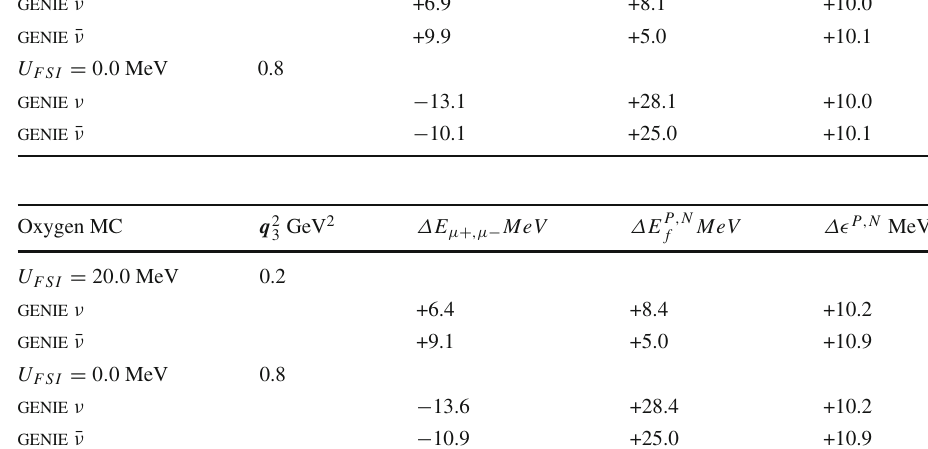
Table 10 Estimates of the difference between the correctly simulated muon, final state nucleon and removal (unobserved) energies and those generated by genie 2 for QE events in carbon